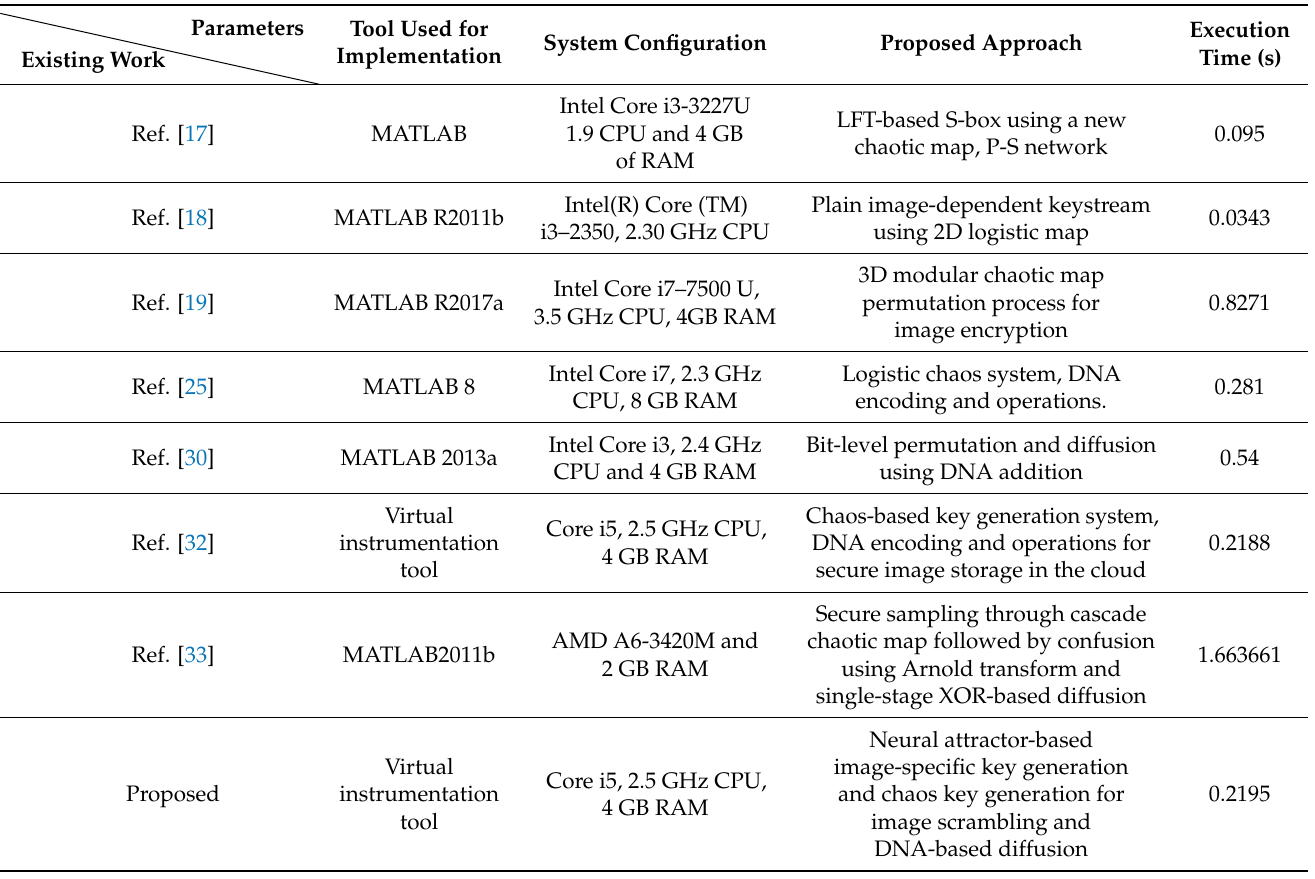
Table 9. Computational complexity comparison with existing